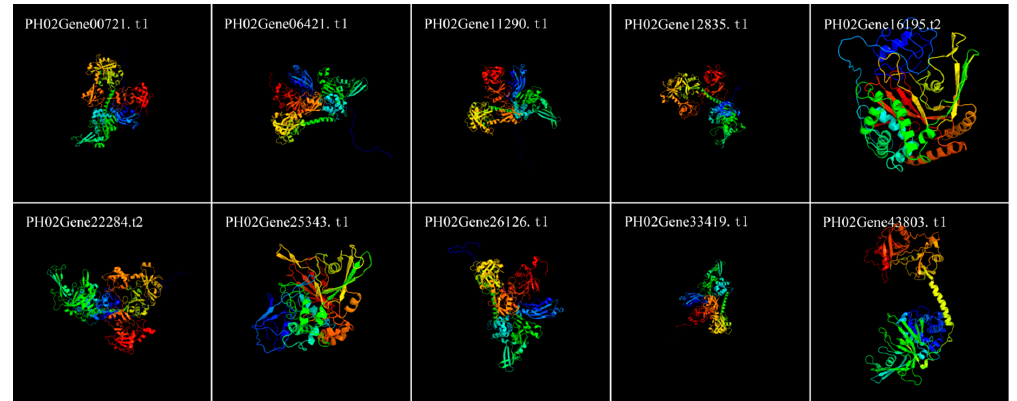
Figure 4. Schematic representation of the ten conserved motifs in PeUBPs. Conserved motifs of the PeUBPs were identified using the online MEME program based on 48 full-length aa sequences. The lengths of the motifs are displayed proportionally. The numbers in boxes (1–10) represent the motif numbers.